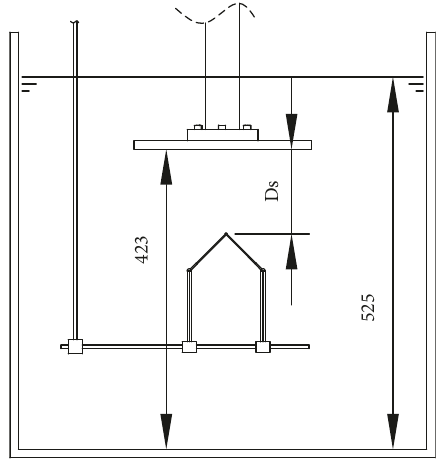
Figure 4: Experimental